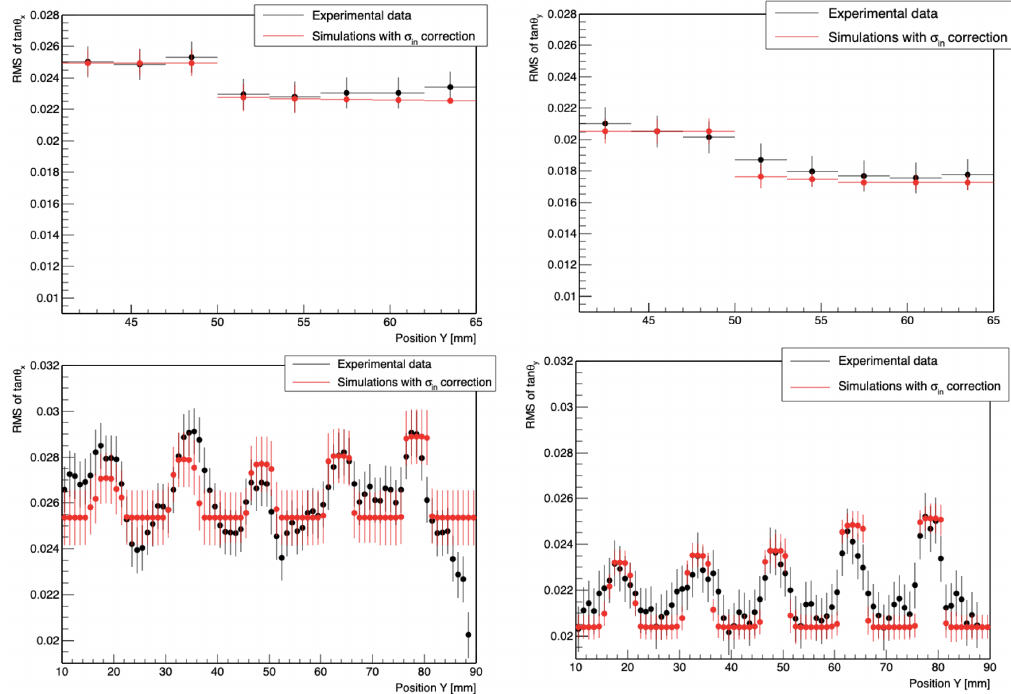
Figure 4. Root mean square (RMS) of tan θ x and tan θ y for Phantom 1 ( top ) and Phantom 2 ( bottom ). Experimental data are reported in black, while the simulation results are in red. The difference in the average RMS of tan θ in x and y is due to the divergence for the pristine